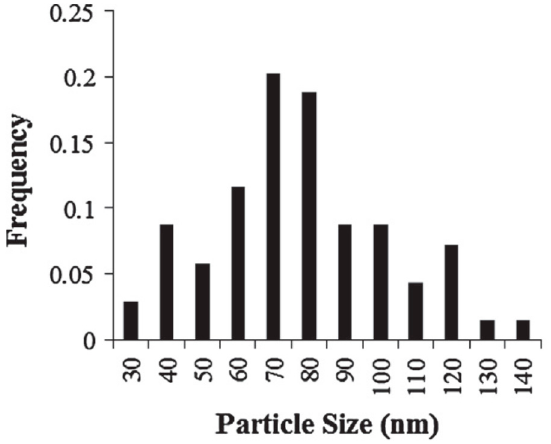
Figure 7. Particle size distribution (50 nm nominal size, SkySpring Nanomaterials). Reproduced from [25], with permission from Elsevier, 2014.